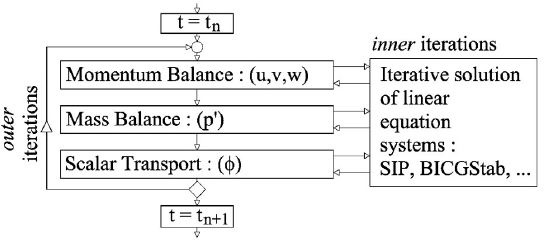
Figure 1. caffa3d.MBRi iteration scheme, Usera et al. (2008)